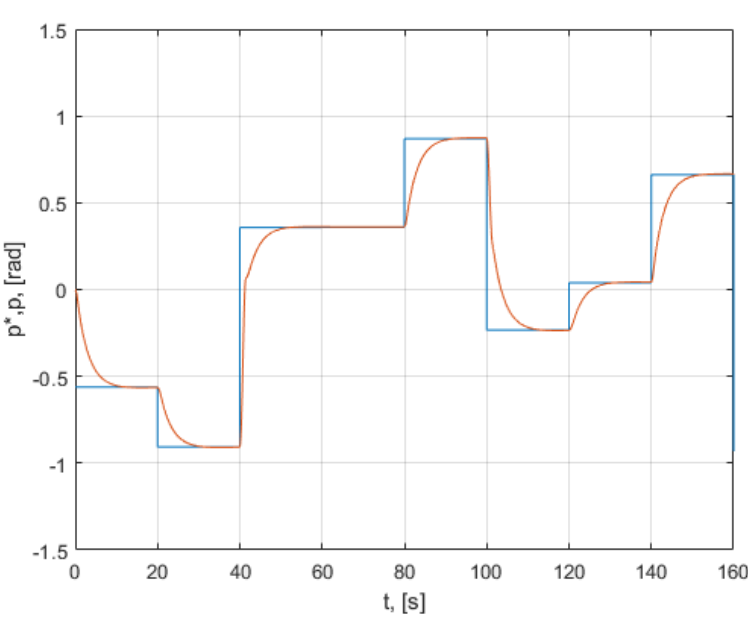
Figure 30. Speed characteristic.